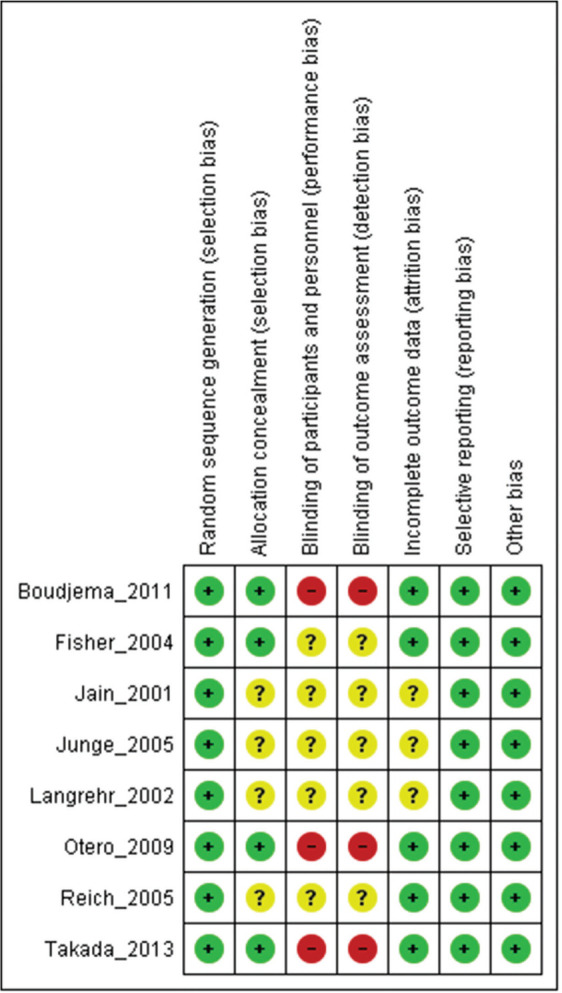
Robins II. Risk of bias evaluation.